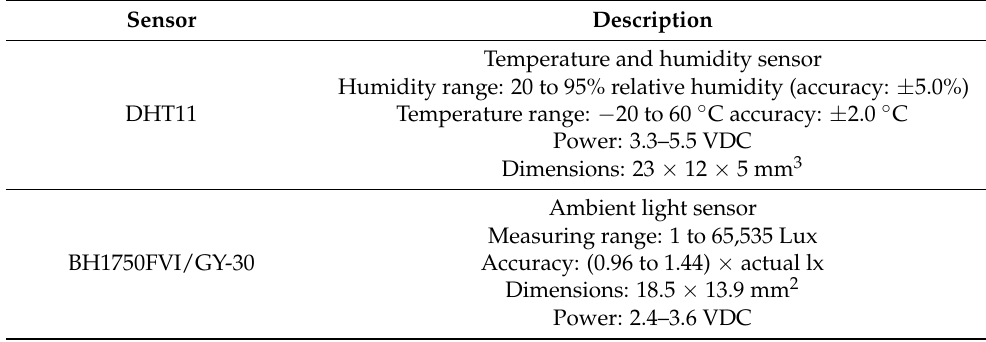
Table 1. Temperature/humidity and light sensors.